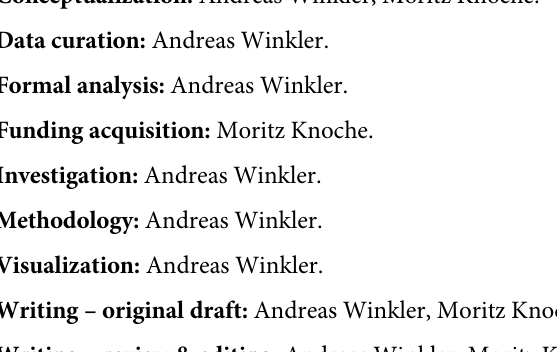
S1 Fig. Volume change of European plum during the 6 day experimental period. A, D, G: Un-treated fruit. B, E, H: Girdled fruit. C, F, I: Detached fruit. A-C: 76 days after full bloom (DAFB), D-F: 104 DAFB, G-I: 132 DAFB. Vertical dashed line indicates the time of treatment. In the morning of the fourth day, fruit pedicels either remained un-treated (A, D, G), or were steam-girdled (B, E, H) or detached (C, F, I), but all fruit remained in situ in the canopy. Data represent individual replicates. (TIF) S2 Fig. Daily xylem (X), phloem (P) and transpiration (T) flows during a 3 day experimen- tal period after steam-girdling or detachment. Representative diurnal time courses of xylem (X), phloem (P) and transpiration (T) flow rates in developing European plum fruit (A: stage II, 76, B: early stage III, 104, C: late stage III, 132 days after full bloom). Flows were calculated from net flows determined for un-treated control fruit, steam-girdled fruit and detached fruit. (TIF) S1 Data.